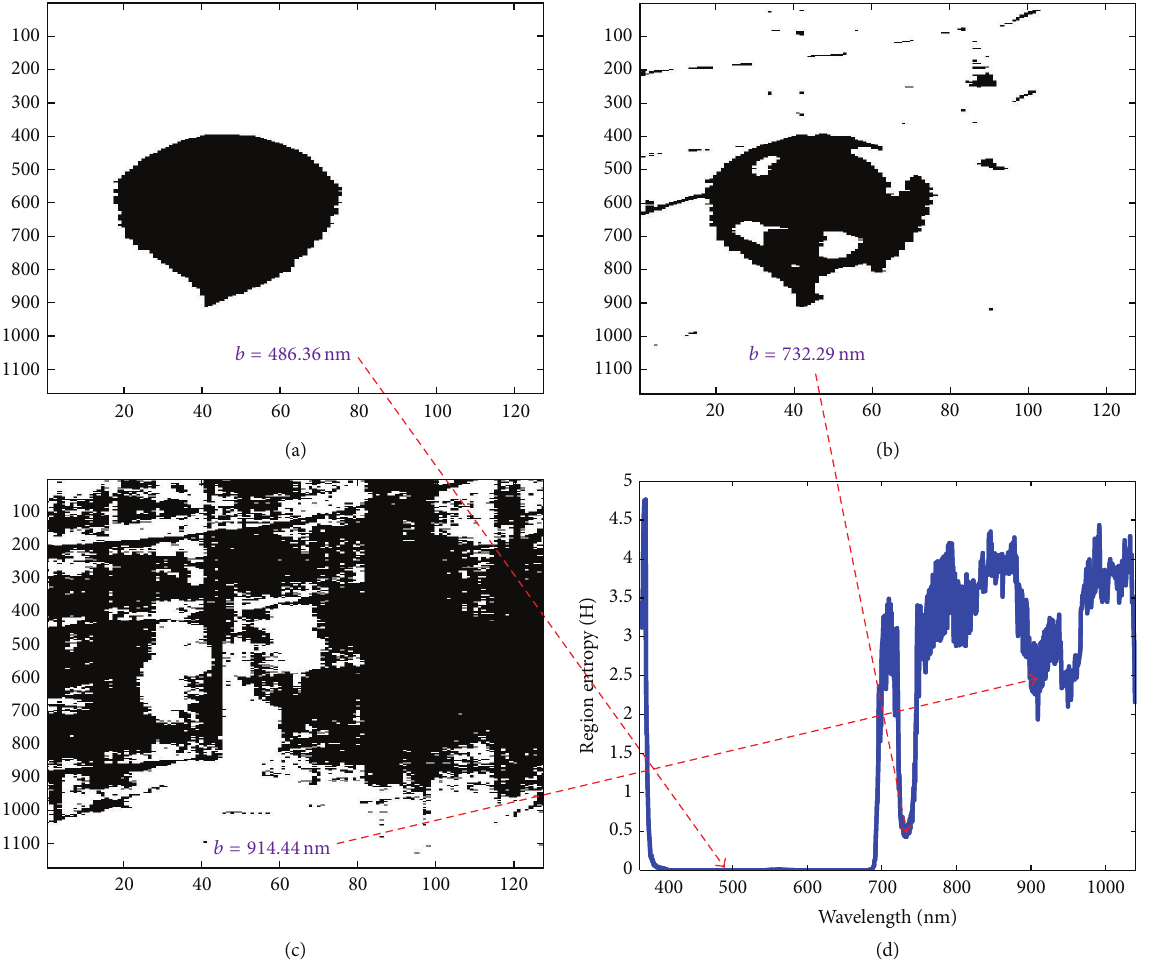
Figure 5: Spatial analysis: the large number of regions produces high region entropy score and two segmented regions produce lowest region entropy